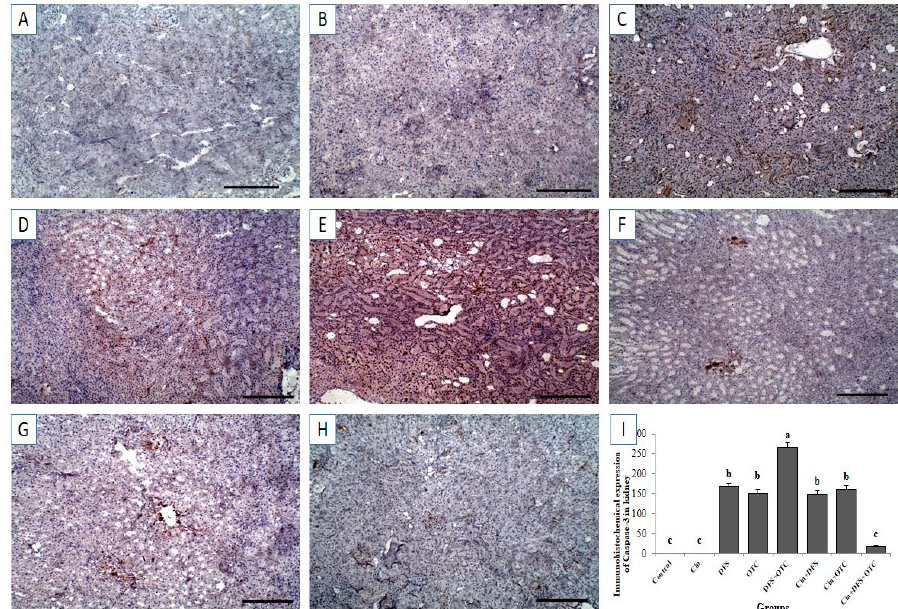
Figure 8. Immunohistochemical staining of rat kidney by Caspase-3. ( A , B ) control and cinnamon groups: Showing negative caspase-3 reaction in the renal sections. ( C , D ) DFS and OTC groups: Revealing strong positive caspase-3 reaction in the hepatocytes. ( E ) DFS+ OTC group: Showing higher expression level of caspase-3 relative to those in rats treated with DFS or OTC alone ( F , G ) DFS + Cin and OTC + Cin group: Revealing reduction in immune reactivity of caspase-3. ( H ) DFS + OTC + Cin group: Showing moderate positive caspase-3 immune staining. ( I ) Quantification of caspase-3 in the kidney tissues in different groups. Data are presented as the mean ± SEM (n = 5), analyzed using one way ANOVA and each bar carrying different letters (a, b, c) is significantly different ( p < 0.05). Scale bar = 100 µm.